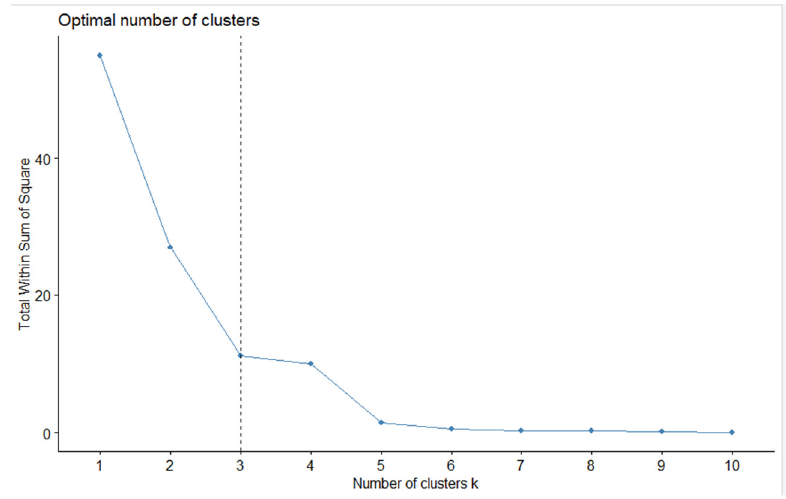
Figure 4. Results of applying the “gap_stat” method to the data.